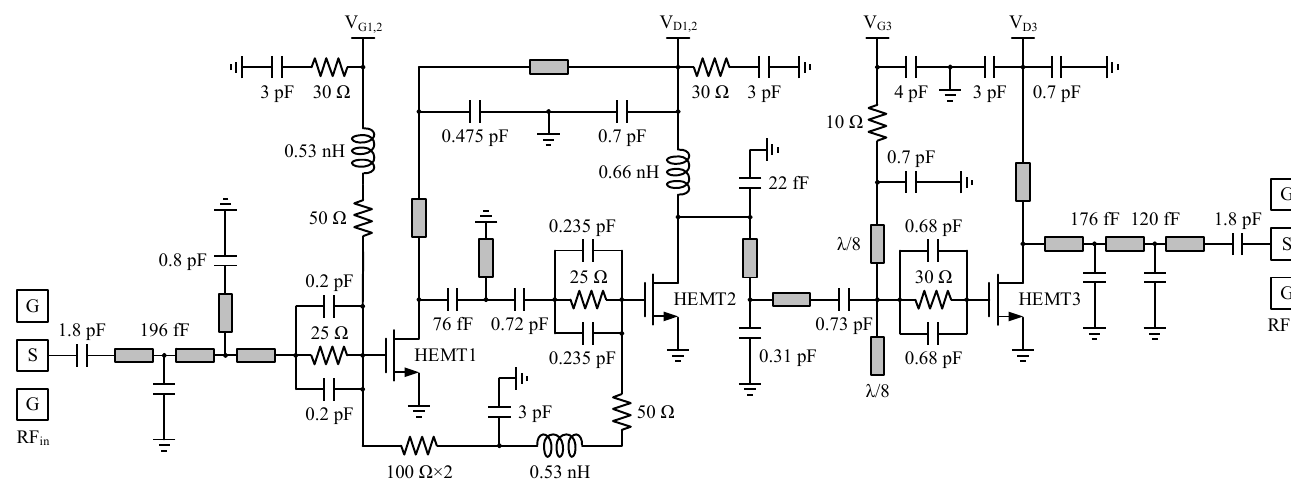
Figure 15. Complete schematic of the three-stage PA.